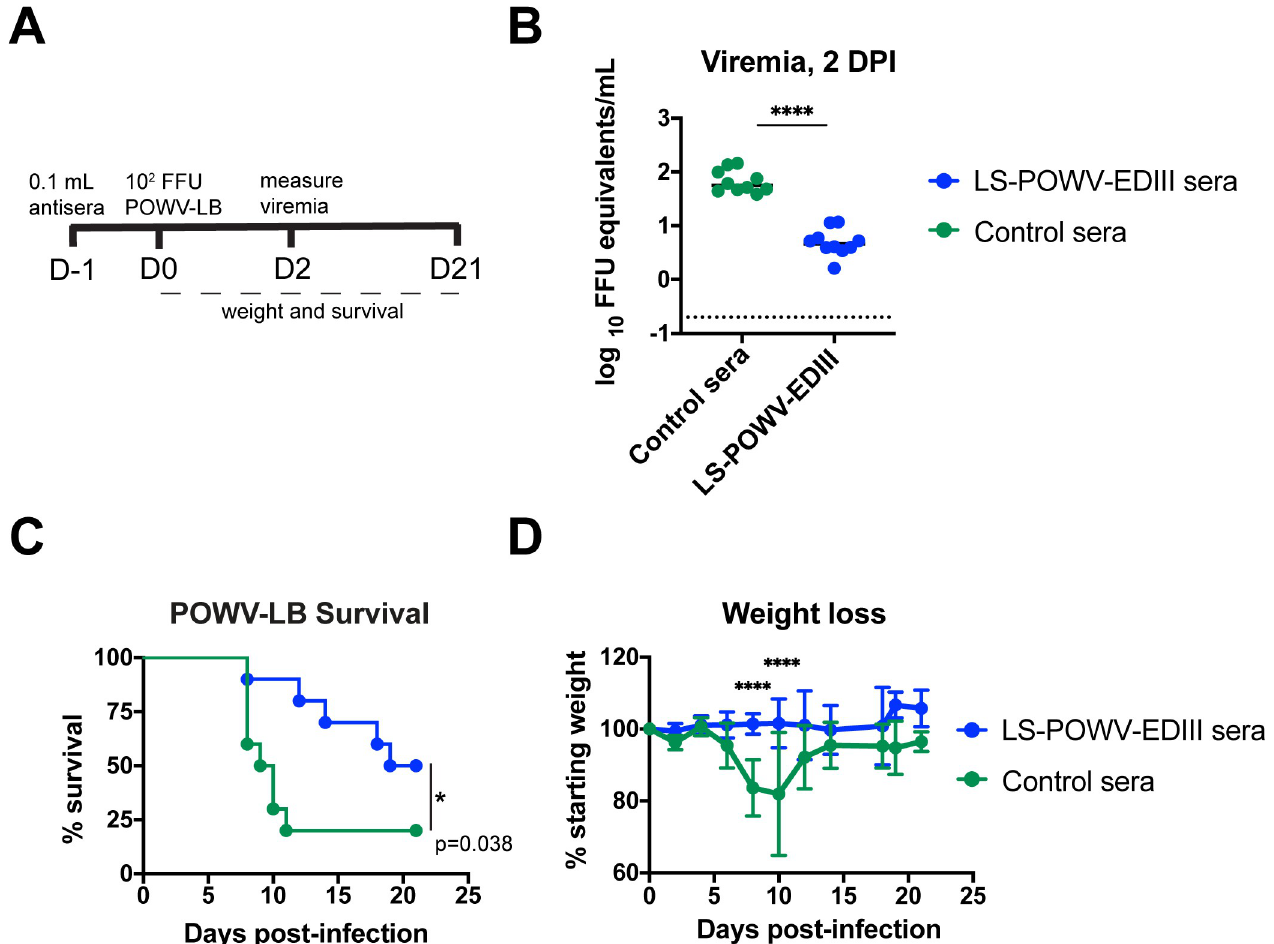
Fig 4. Serum from immunized mice protects against authentic POWV-LB challenge. (A) Timeline of passive serum transfer challenge. ( B ) Viremia, ( C ) survival, and ( D ) aggregate weight from passive serum transfer challenge against POWV-LB. 11-week-old C57BL/6J mice were administered 100 μ L of pooled sera from na ï ve or LS-POWV-EDIII vaccinated mice and then challenged with 10 2 FFU POWV-LB 24 hours later. Viremia was quantitated by qRT-PCR 2 days post-infection. Statistical analysis: (B) Two-tailed Mann Whitney test, (C) Log-rank Mantel-Cox test, and (D) Two-way ANOVA with Sidak’s multiple comparison test. ( � , P < 0.05; ���� , P <